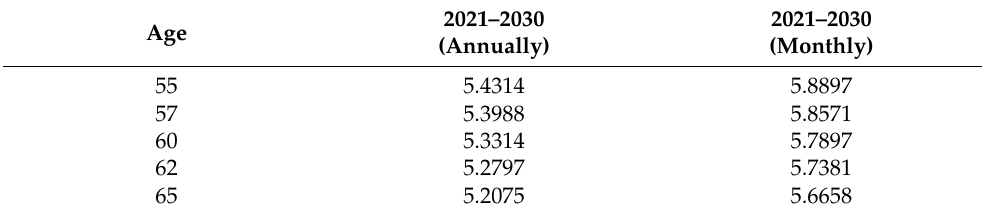
Table 6. Projected Annuity Factor Cost for Retirement Age—RH Estimates.